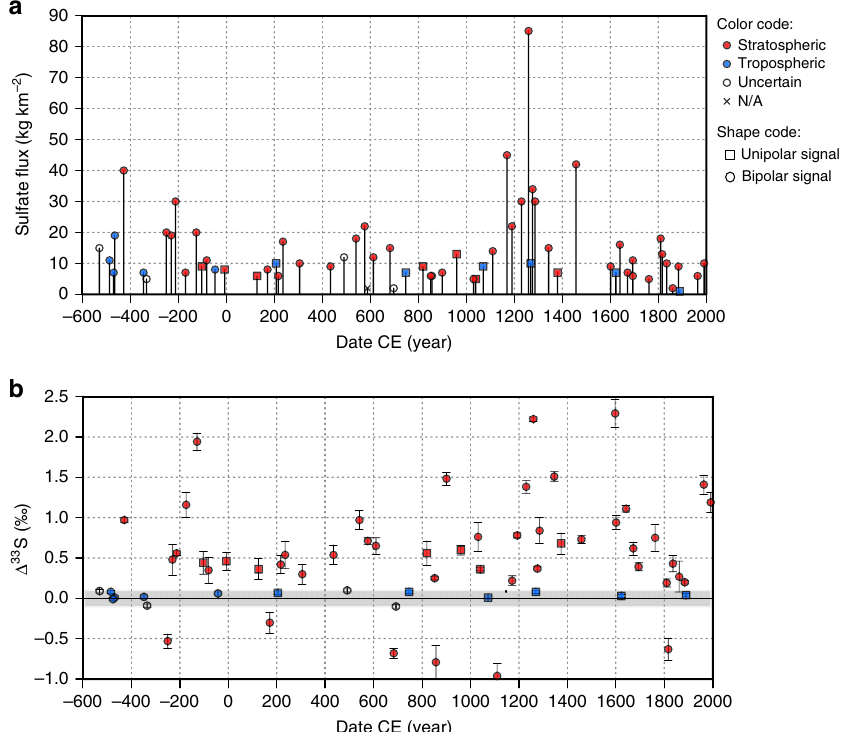
Fig. 1 Time series of volcanic sulfate deposition at Dome C, Antarctica. a Sulfate deposition for volcanic events recorded in Dome C (Dome C volcanic index). Red colored symbols are stratospheric eruptions identi fi ed based on Δ 33 S proxy. Blue colored symbols are eruptions that do not display any sulfur isotope anomalies, and therefore are presumed to be tropospheric eruptions. Empty dots are uncertain events because the isotopic signal falls in the uncertainty of the method. Round shape illustrates the eruptions found to be bipolar signals in Sigl15, while square shapes represent the eruptions found to be unipolar (Southern Hemisphere eruptions) in Sigl15. Consequently, blue round dots and red squares are eruptions for which the isotopic and the bipolar method display different results. The isotopic records of Pinatubo and Agung are added from a prior study by Baroni et al. 18,19 . The fl ux is the volcanic sulfate deposition fl ux (cumulative sum integrated over each event), corrected from background, calculated from concentrations measured in this study. Dating is provided by Sigl et al. 11 . b Maximum sulfur anomaly for volcanic events recorded in Dome C. Color and shape code is the same as a . Values below 0.1 ‰ (in the gray area) fall within the variability obtained on background samples. They were therefore not corrected from background, to avoid false stratospheric signal ( Δ 33 S > 0.1 ‰ ) due to correction, and are considered tropospheric or uncertain, if close to 0.1. Data are available in Supplementary Table 1. Error bars are 1 standard deviation